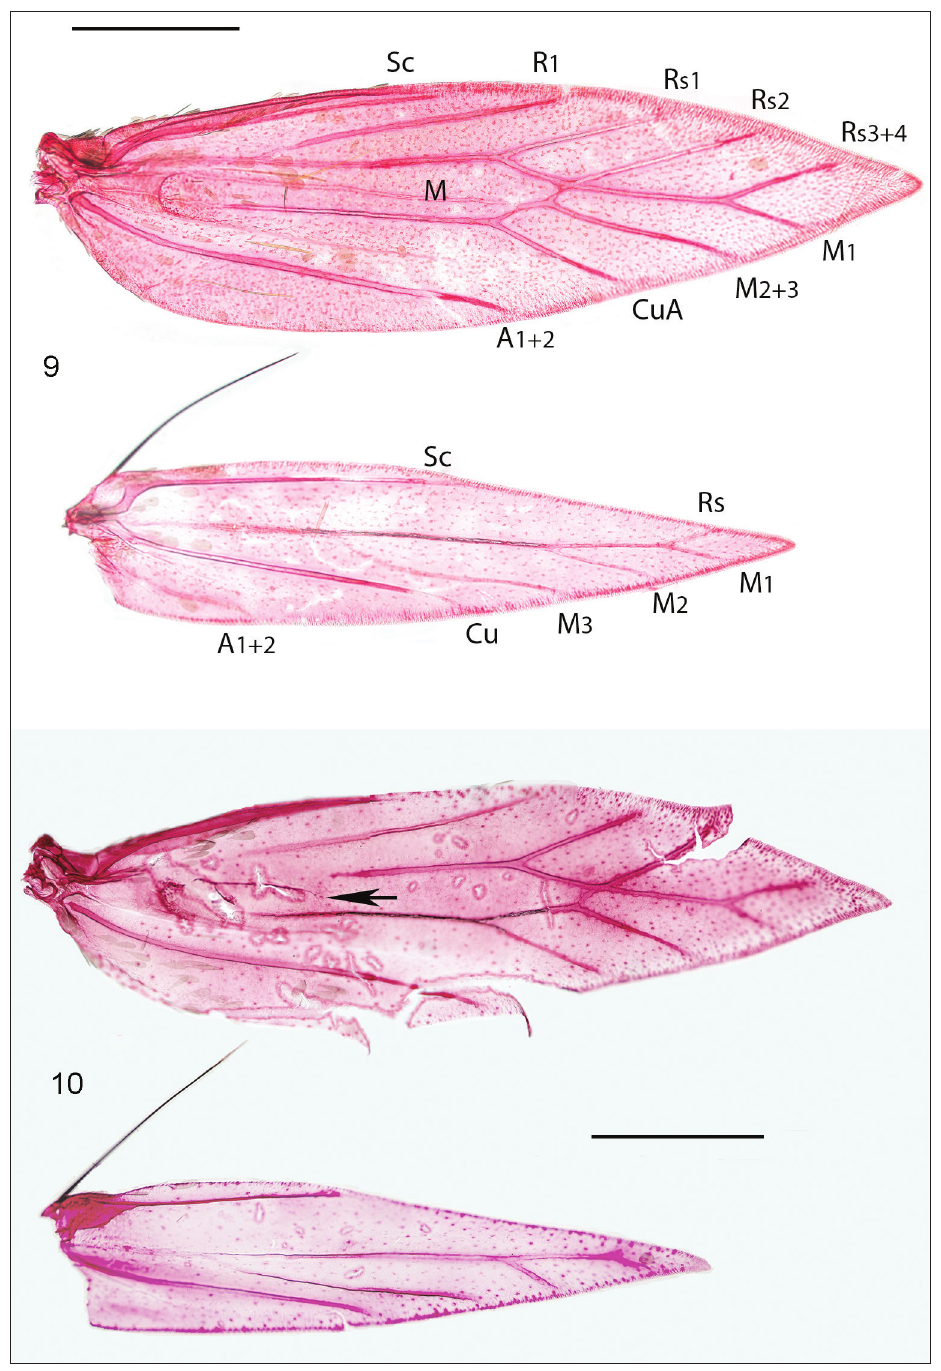
Figures 9–10. Antispila , male venation. 9 A. treitschkiella with veins indicated, slide EvN4257. 10 A. petryi , slide EvN5012, the arrow indicates the curved M. Scales 0.5 mm. Photos Erik van